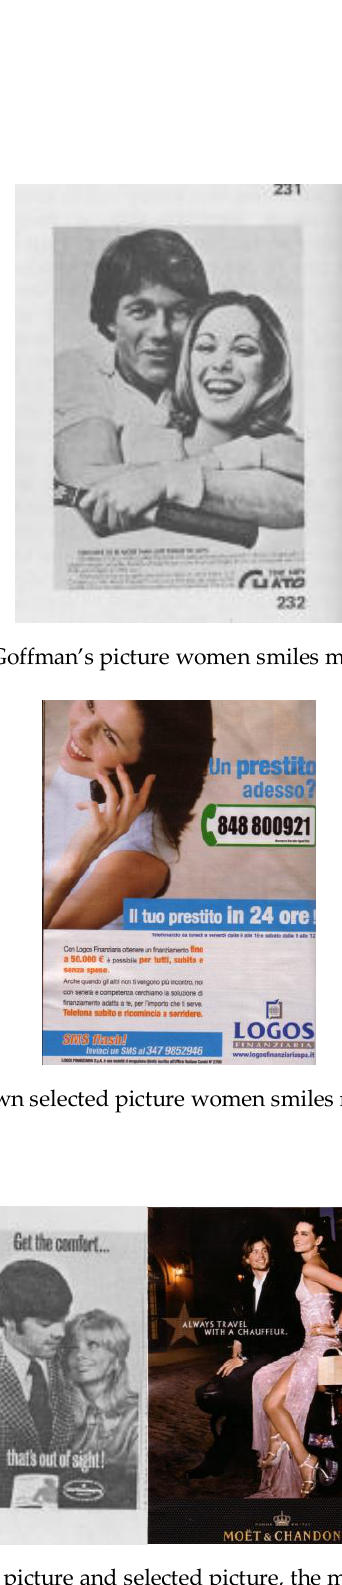
Figure A8. Goffman’s picture and selected picture, the man looks at the